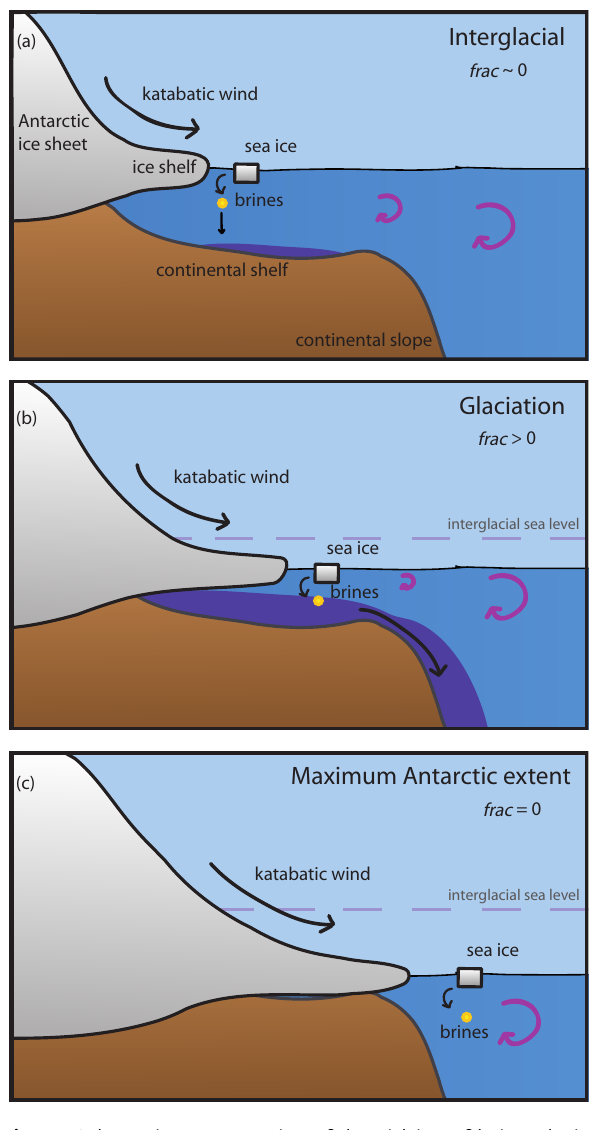
Fig. 7. Schematic representation of the sinking of brines during (a) interglacial, (b) glacial and (c) deglacial periods. The main drivers of the fraction of salt sinking to the deep ocean (frac) are the Antarctic ice sheet extent on the continental shelf and sea level which govern the volume of water above the continental shelf. The less water there is, the less brines are mixed and the more they can sink into the deep ocean. When sea ice formation is shifted to the open ocean, brines are mixed and the sinking